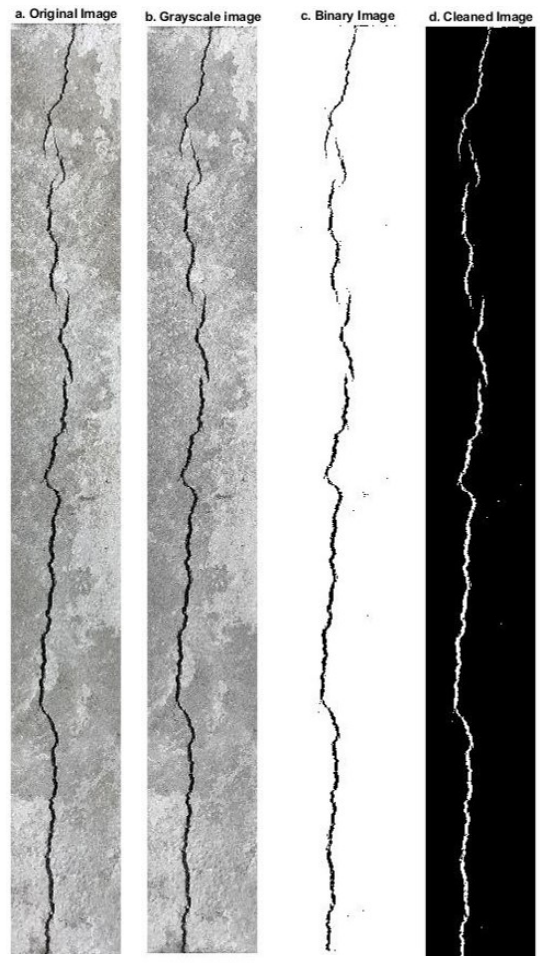
Figure 12. Image processing steps.